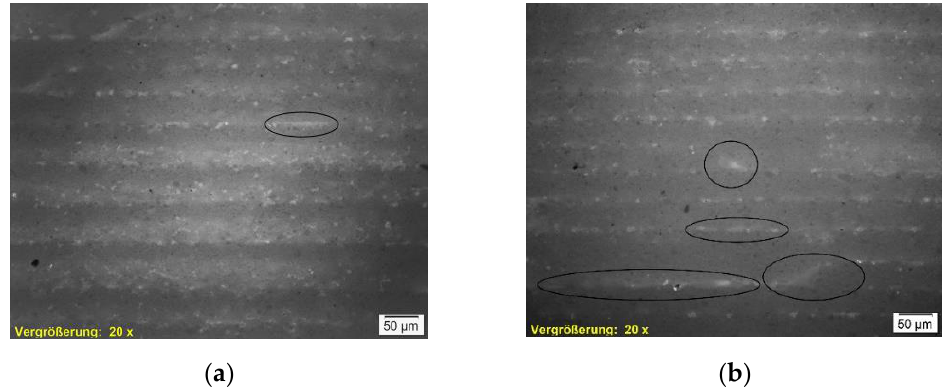
Figure 11. Microscopic images of selected samples (magnification 20 ×) depicting major flaws for Drying Point 3 ( b ) compared to Drying Point 1 ( a ). Nevertheless, ( b ) shows smaller proportions of porosities, indicating increased density. ( a ) 50;1;4.2; ( b ) 50;3;4.2.